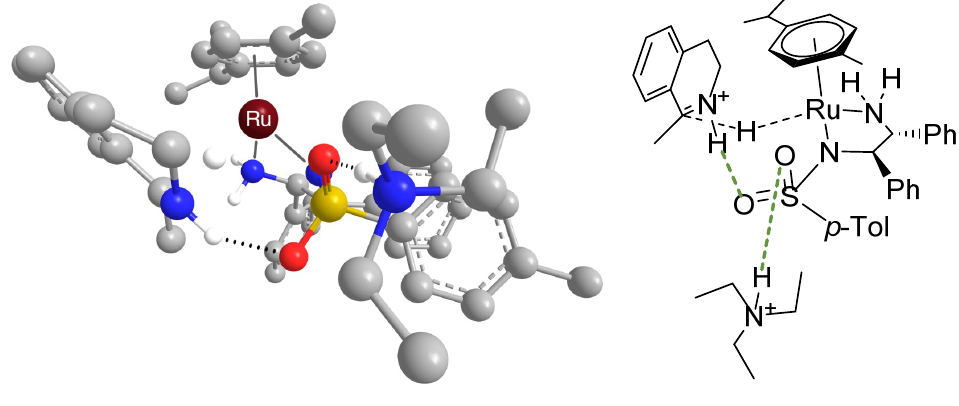
Figure 4. Transition state of hydrogenation of 1-methyl-DHIQ with [RuH( η 6 - p - NH + hydrogen-bonded to one oxygen atom of the cymene)( R , R )-TsDPEN] with Et 3 sulfonyl group (optimized